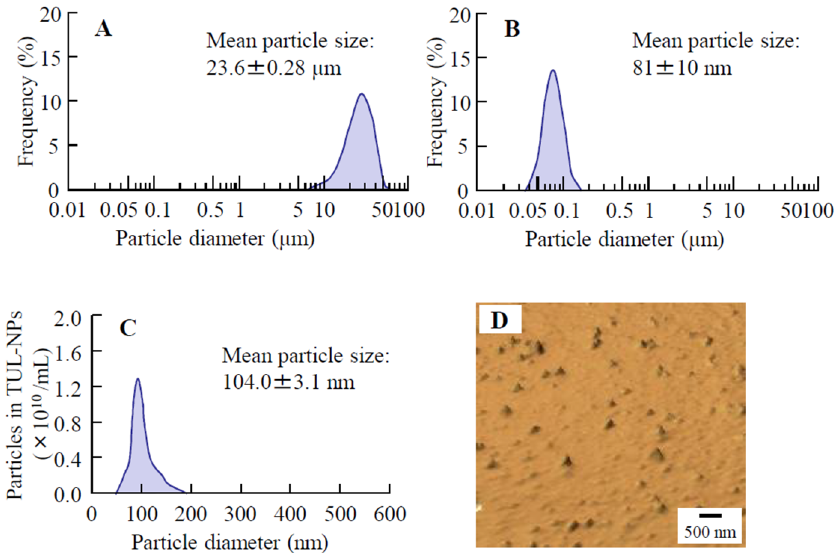
Figure 1. Particle size frequencies and SPM image of TUL in TUL-MP and TUL-NP dispersions. Particle distribution of TUL-MP ( A ) and TUL-NP ( B ) dispersions using laser diffraction particle size analyzer. Particle distribution ( C ) and SPM image ( D ) of TUL-NPs in TUL-NP dispersions using dynamic light-scattering analyzer and SPM-9700 instrument, respectively. Particle sizes of bead-mill-treated TUL particles were on the nanoscale, i.e., 30–180 nm.